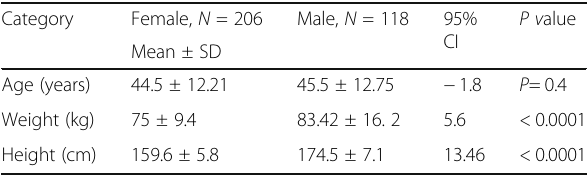
Table 1 Demographic criteria of the study sample Category